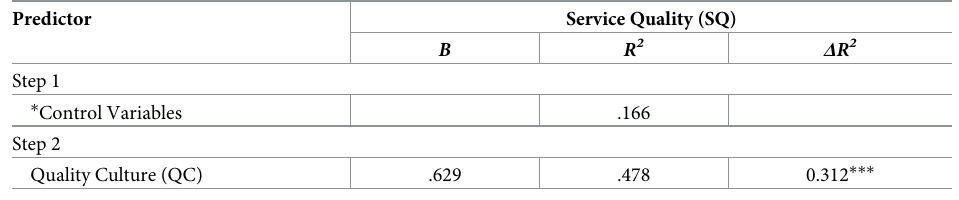
Table 7. Results of regression analysis for service